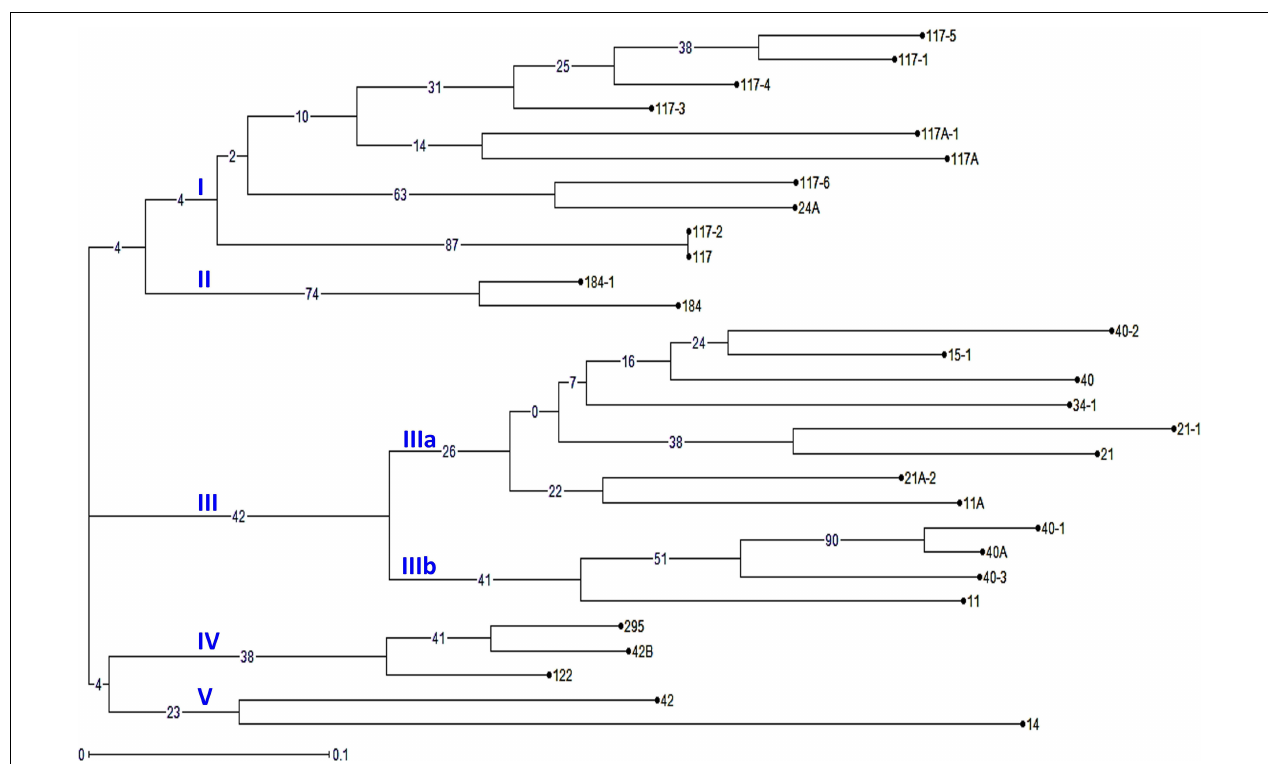
FIGURE 3 | The phylogenetic tree of P. graminis f. sp. tritici pathotypes from the Indian subcontinent based on their avirulence/virulence phenotypes on stem rust differentials. The characters at the base of selected branches indicate the number of the virulence group and